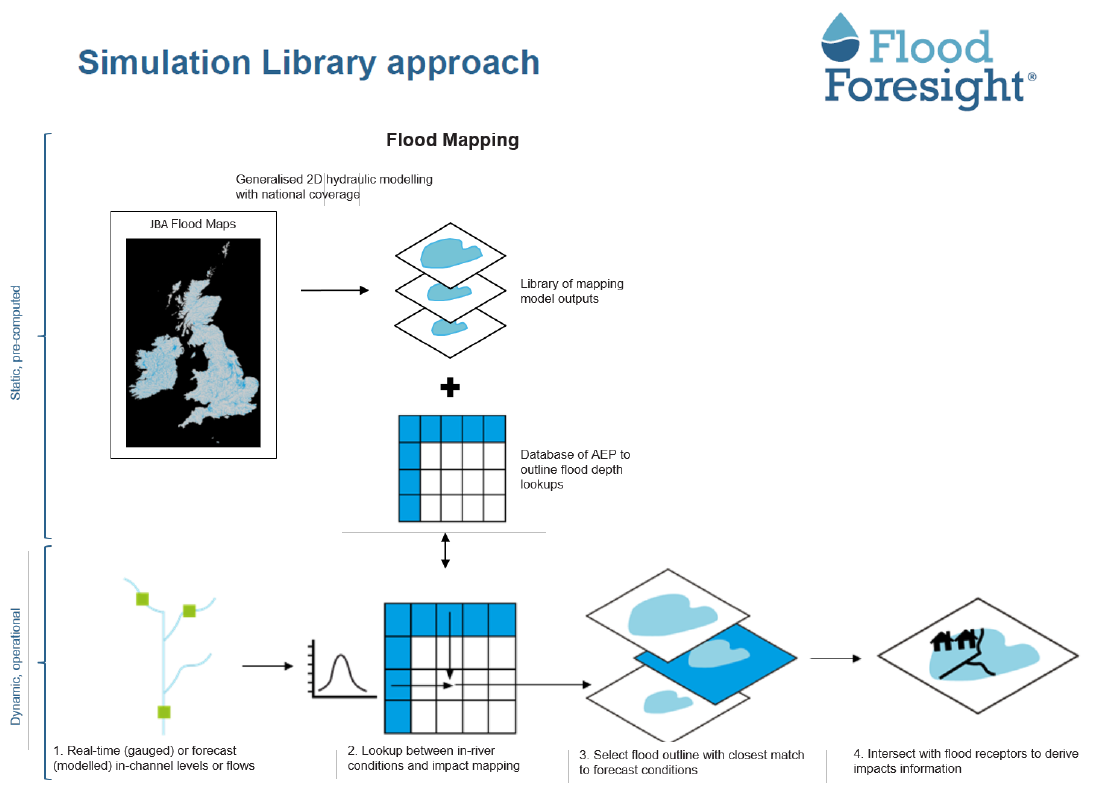
Figure 1. Simulation Library approach.